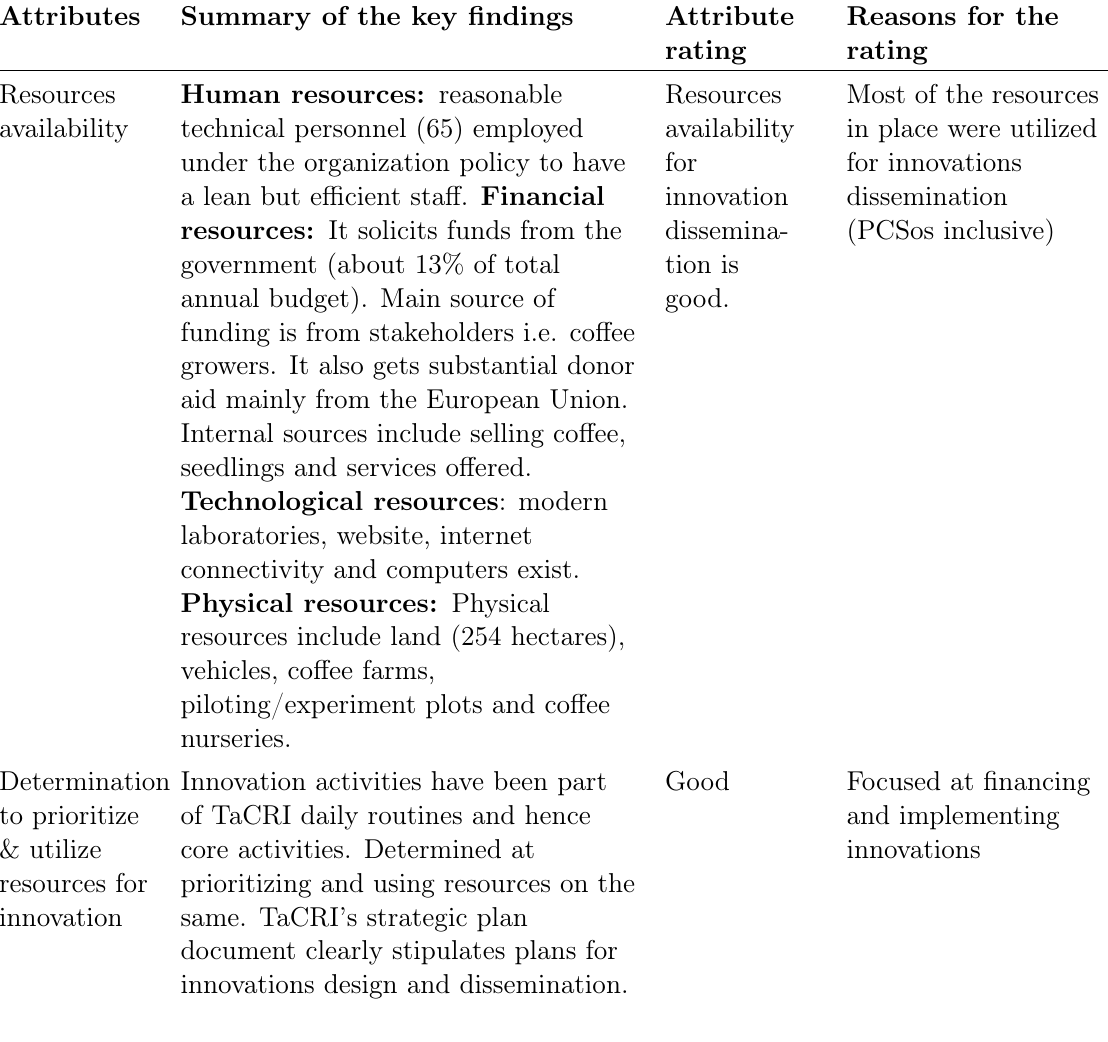
Table 5. TaCRI resources capability attributes Attributes Summary of the key findings Attribute